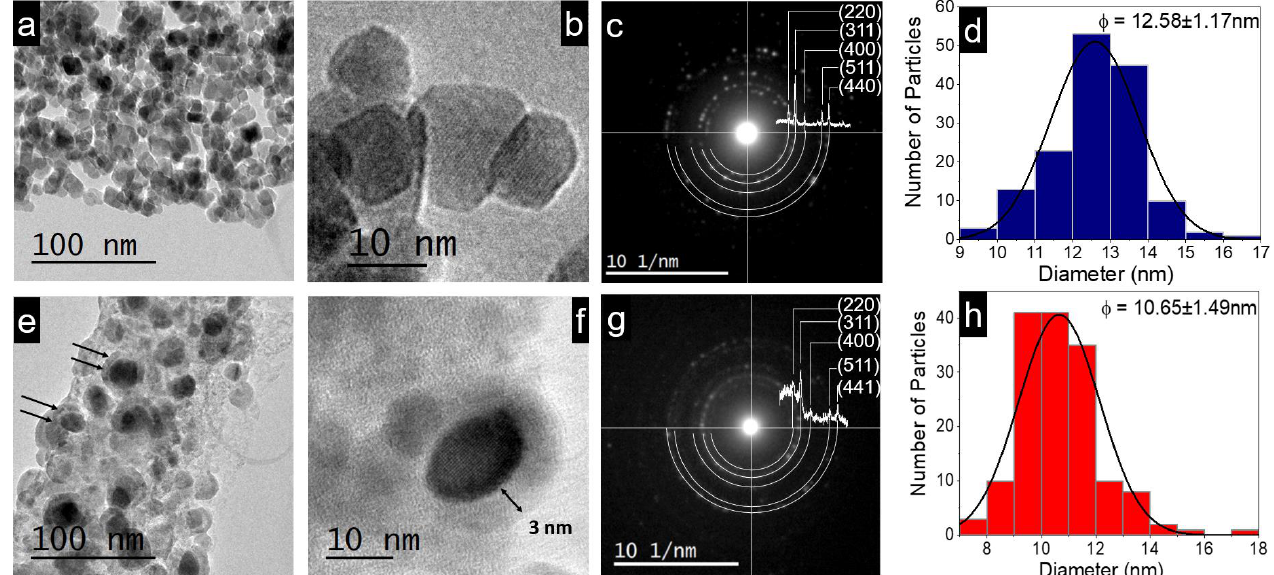
Figure 4. TEM micrographs for ( a – d ) MNPs and ( e – h ) G-M@T samples. In ( e ), the black arrows indicate the organic cover over the SPIONs. In ( c , g ), the SAED results are in agreement with XRD analysis corresponding to magnetite phase as cores (black contrast in the micrograph) and organic shell (gray contrast in ( e , f )). The histograms ( d , h ) show the mean particle size fitted to Gaussian